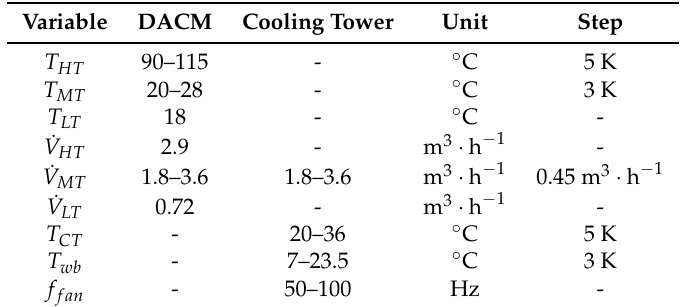
Table 3. Validity range of the chiller and cooling tower performance maps.